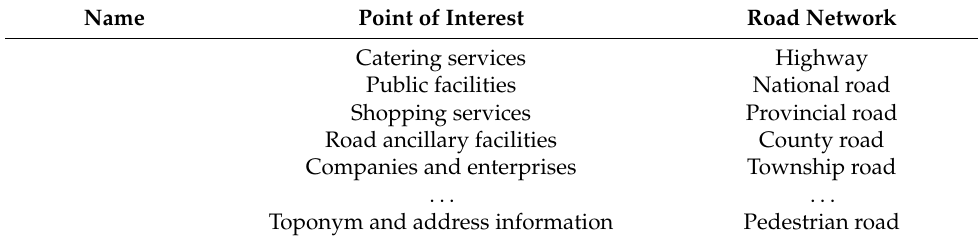
Table 1. POI and road network data type example